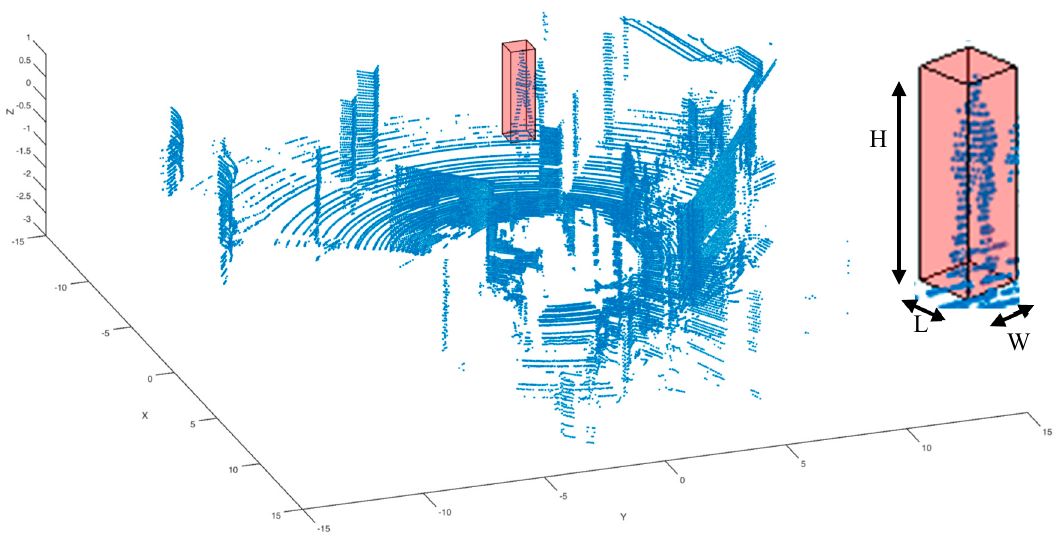
Figure 6. Pedestrian sample captured with software tools over a frame from the 3D LIDAR.